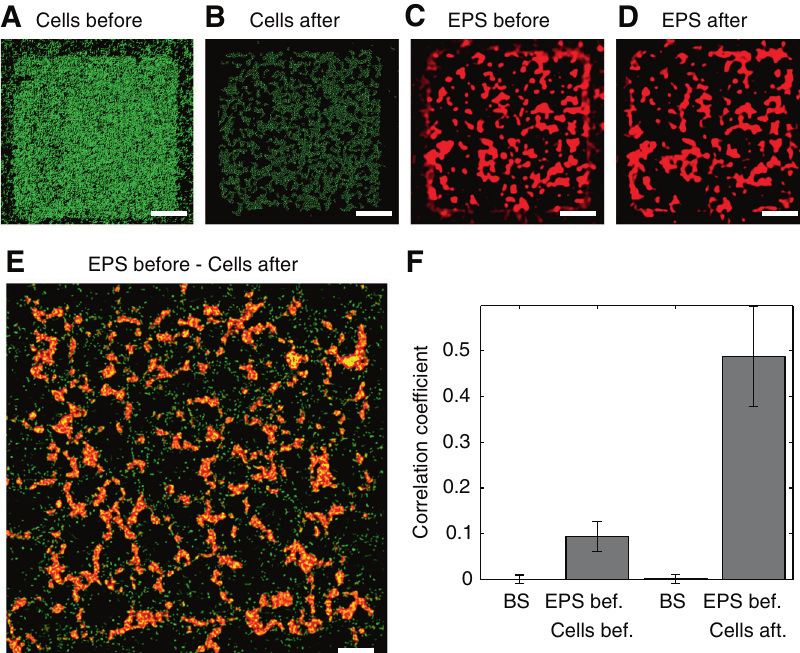
Fig. 4 The hole pattern correlates with the EPS distribution. a , b Distribution of fl uorescently labeled P. aeruginosa after 8 h of bio fi lm growth, before ( a ) and after ( b ) the passage of an air bubble. c , d Distribution of EPS, fl uorescently labeled using lectins (Methods), at the same times and position as a , b . Scale bars, 100 µm. e Overlay of the EPS distribution before the passage of the bubble ( red ) and the bacteria distribution after the passage of the bubble ( green ). Data are from a different experiment than a – d . Scale bar, 50 µm. f Normalized cross-correlation between the EPS distribution before the passage of the bubble and the cell distribution before (second bar from left) and after (fourth bar from left) the passage of the bubble. Error bars correspond to the standard error of the mean over three replicate experiments. The fi rst and third bars represent results from a bootstrapping analysis (BS), where the EPS distribution before the air bubble is correlated with random permutations of the cell distribution before ( fi rst bar ) and after ( third bar ) the passage of the bubble. Note the lack of correlation in these